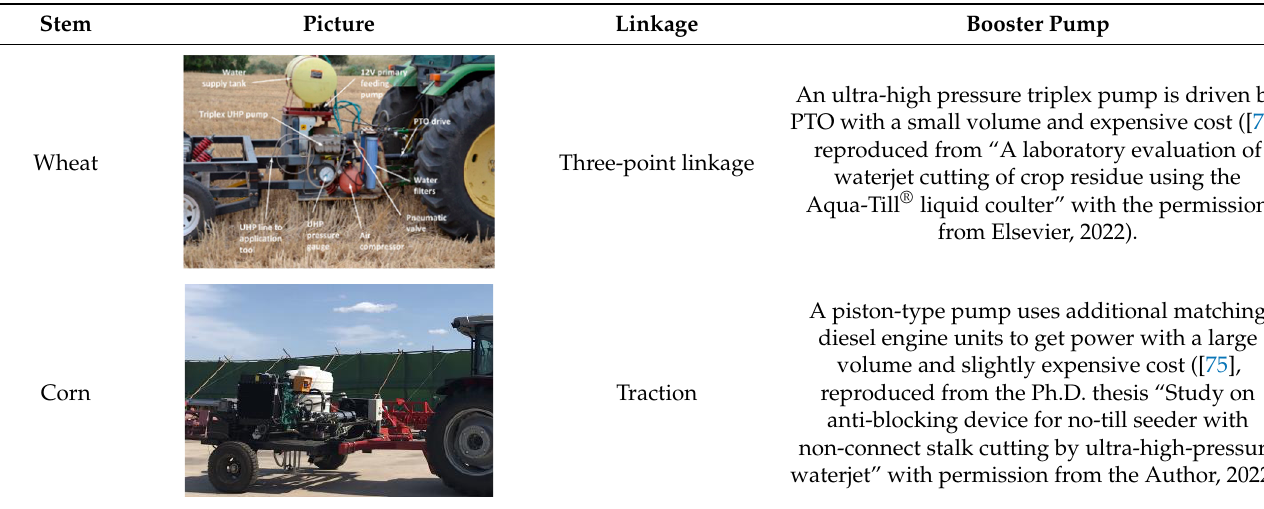
Table 1. Water jet cutting stem devices for anti-blocking.